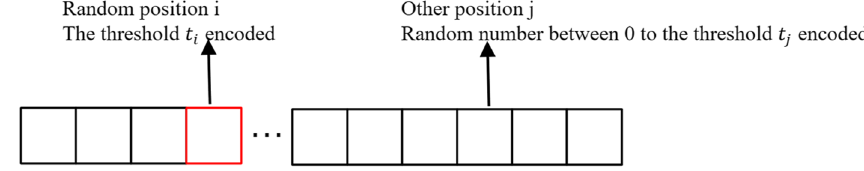
Fig. 5 Schematic of chromosome